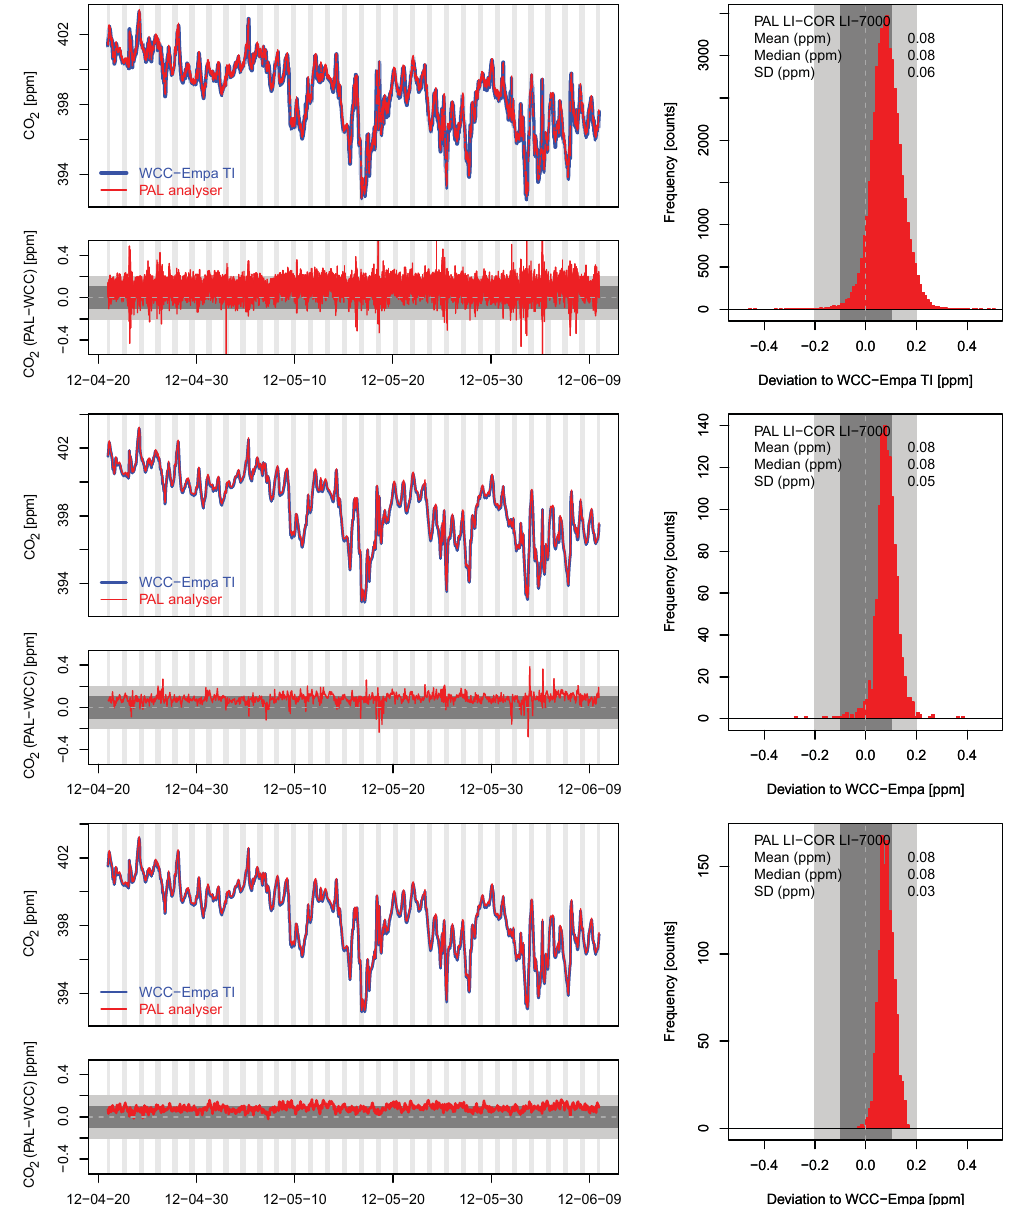
Figure 6. CO 2 comparison at PAL between the WCC-Empa travelling instrument and the PAL LI-COR LI-7000 instrument. Left: CO 2 time series and CO 2 bias vs. time. Right: deviation histogram. Upper set: 1min data; middle set: 1h data, calculated from all available 1min values; lower set: 1h data, calculated from 1min values with concurrent PAL and WCC-Empa data. The grey areas correspond to the WMO/GAW compatibility (dark grey) and extended compatibility (light grey) goals; vertical grey bars (left diagrams) illustrate when different inlets were used (see text for